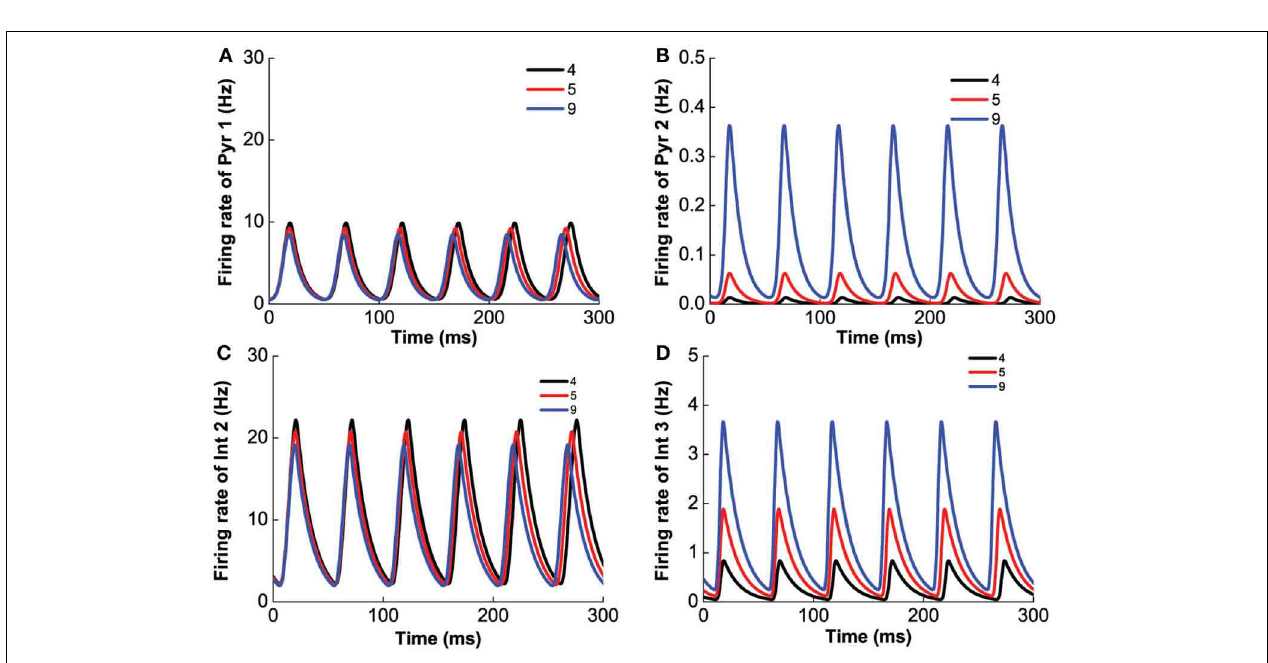
Dependence of firing rate of pyramidal cell (D2 + 5-HT1A) on [DA] 1 . (C) The firing rate of interneurons (D1 + 5-HT1A) depends on [DA] 1 . (D) Frequency of oscillation increases with the increase of [ DA ] 1 before the agonist/antagonist shuts off the oscillation. Insets: firing rates of two types of pyramidal cells over time with [DA] 1 = 1nM (left), and [DA] 1 =3 nM (right).